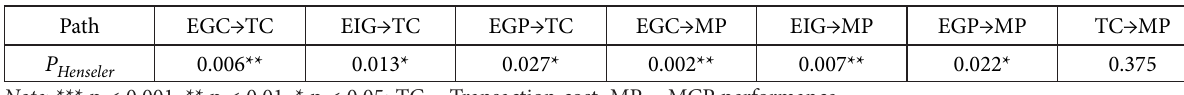
Table 5. Multi-group comparison test